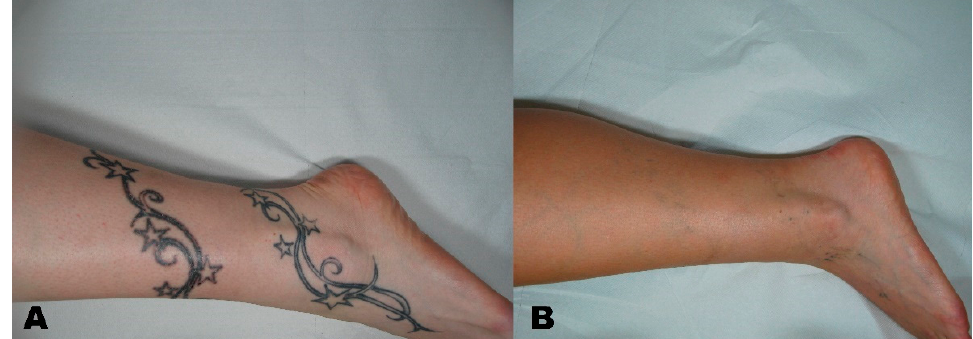
Figure 4. ( A ) Picture before starting tattoo removal treatment, and ( B ) the same region at the 6-month follow-up, after all tattoo removal sessions had been completed.